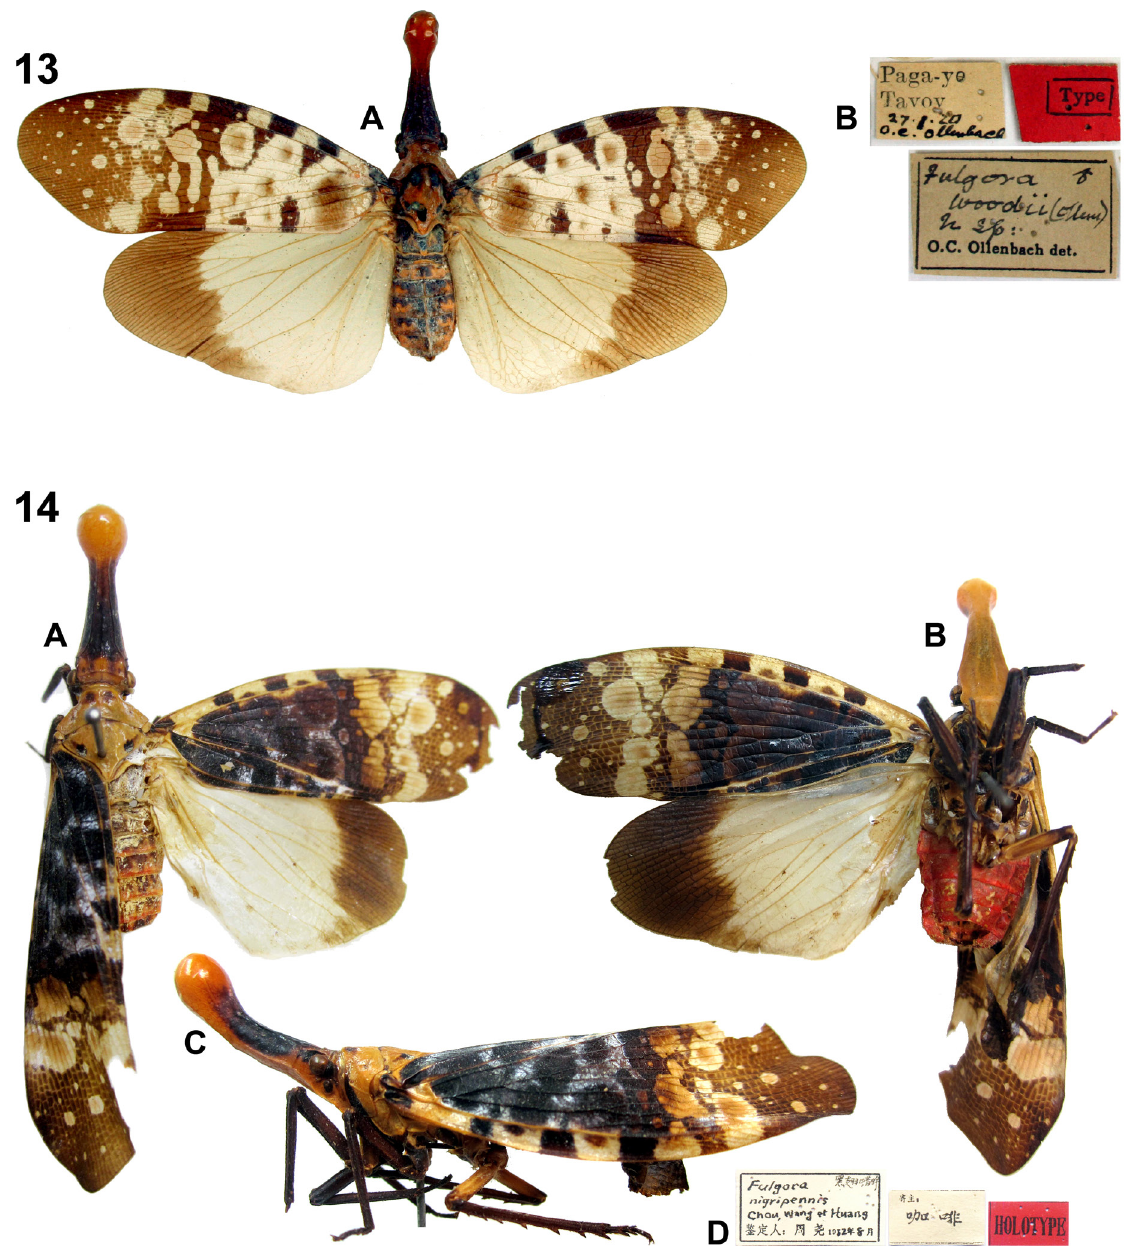
Figs 13–14. Pyrops clavatus (Westwood, 1839), type specimens of the synonymised species. 13 . Fulgora woodi Ollenbach, 1929, syntype, ♂ (NFIC, photographs by S. Singh). A . Habitus, dorsal view. B . Labels. Wingspan: 80 mm — 14 . Fulgora nigripennis Chou & Wang, 1985, holotype, ♂ (NWAFU, photographs by D. Qin). A . Habitus, dorsal view. B . Habitus, ventral view. C . Habitus, lateral view. D . Labels. Total length: 37